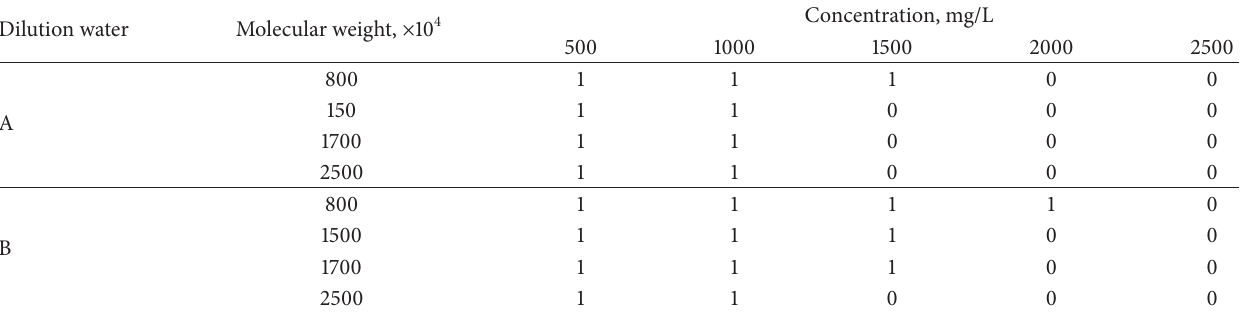
Table 7: The matching relationship plate for reservoirs with permeability 661 × 10 −3 𝜇 m 2 .